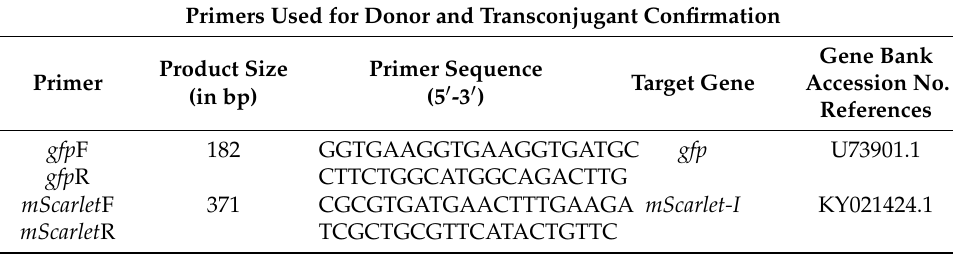
Table 2. Primers used the detection of fluorescent markers in the donor and recipient